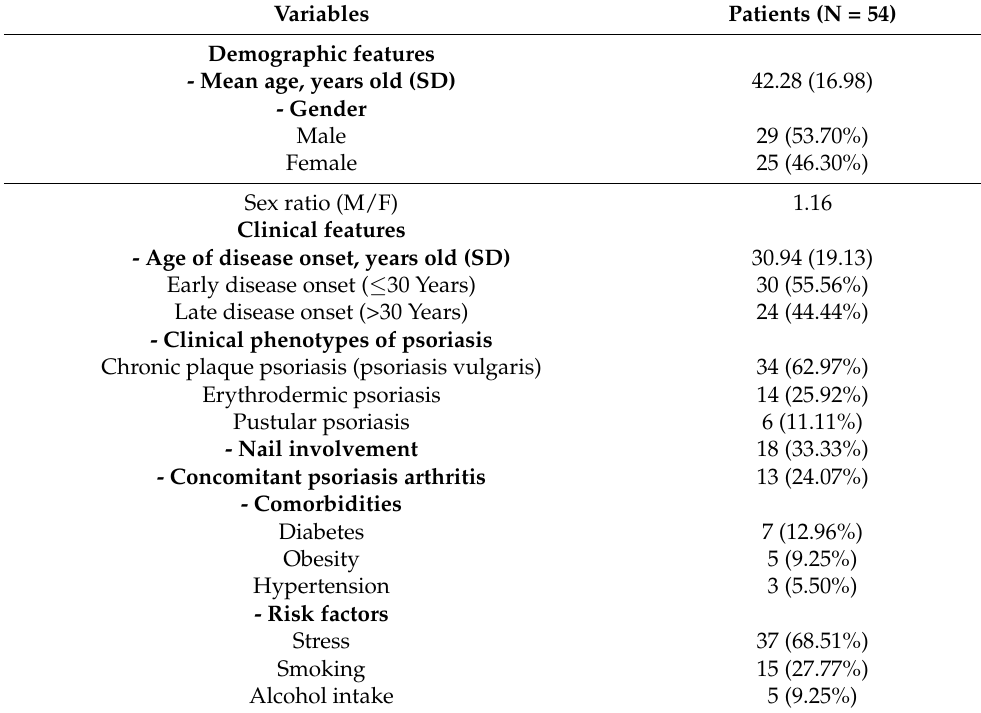
Table 1. Demographic and clinical features of the 54 psoriatic